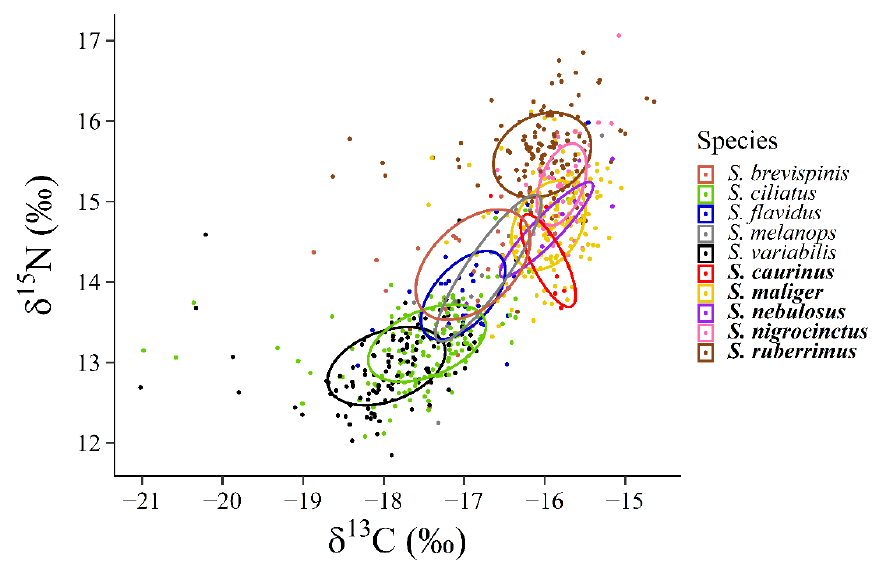
Figure 3. Standard ellipses for the rockfish assemblage. Species names in bold font are demersal and pelagic species are in non-bold font.